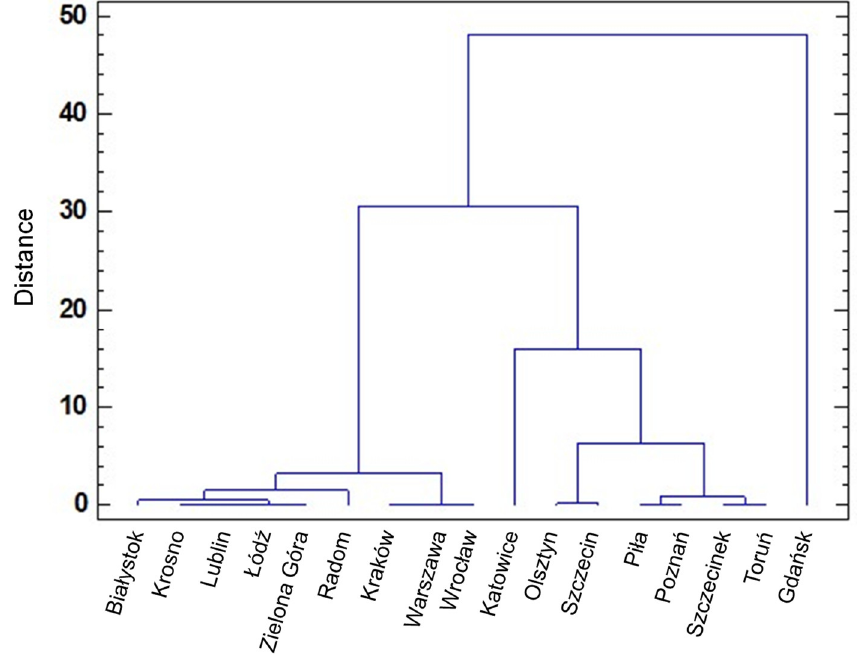
Figure 3. Ward’s clustering of HEV strains detected in wild boars from different RDSFs.